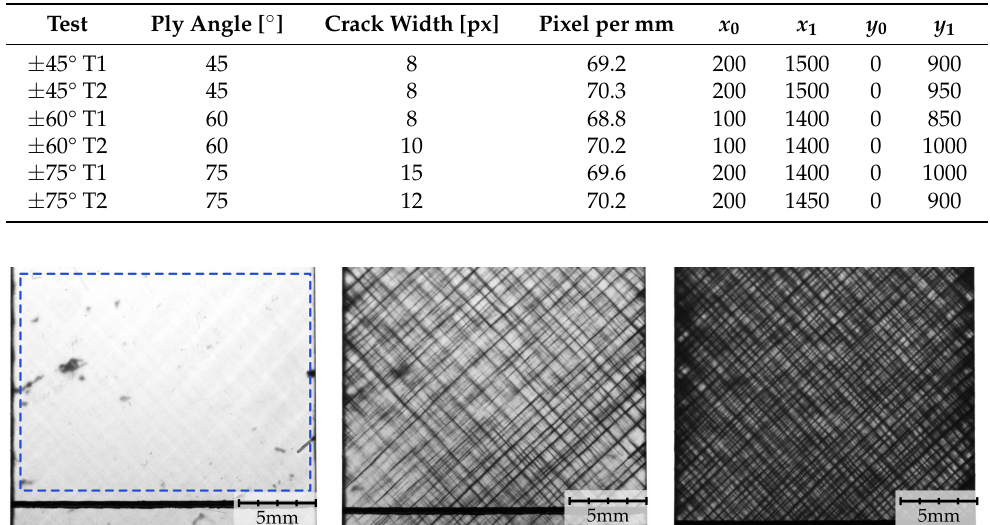
Table 2. Input parameters for CrackDect. The coordinates of the region of interest x 0 to y 1 are given in pixel.